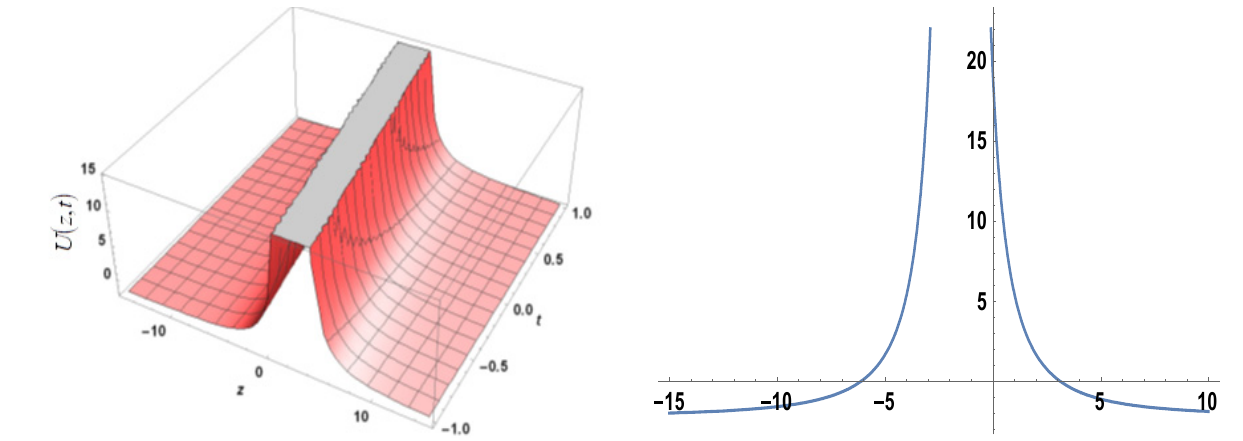
Figure 13. The 3D and 2D plots of Equation (63) for various values of parameters.